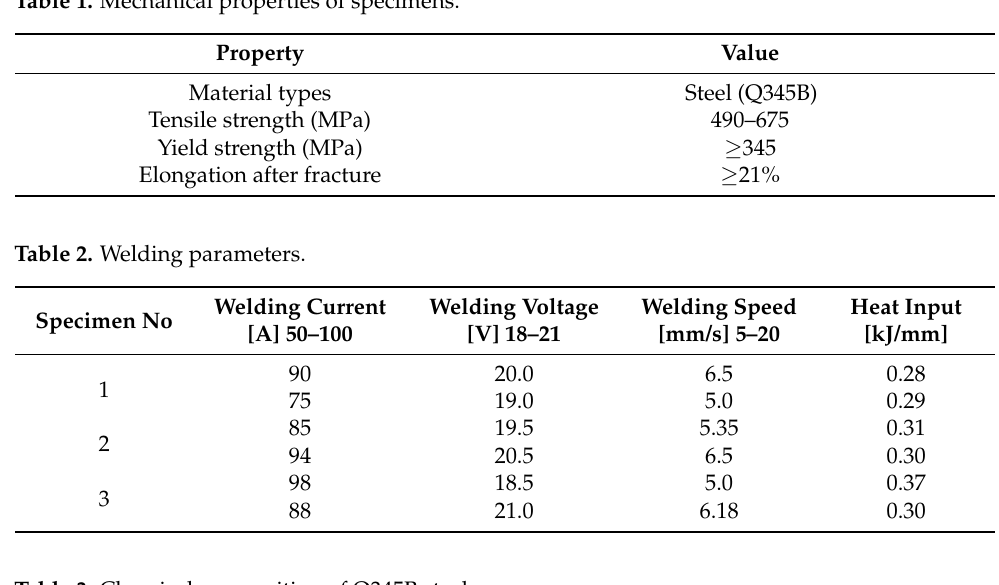
Table 3. Chemical composition of Q345B